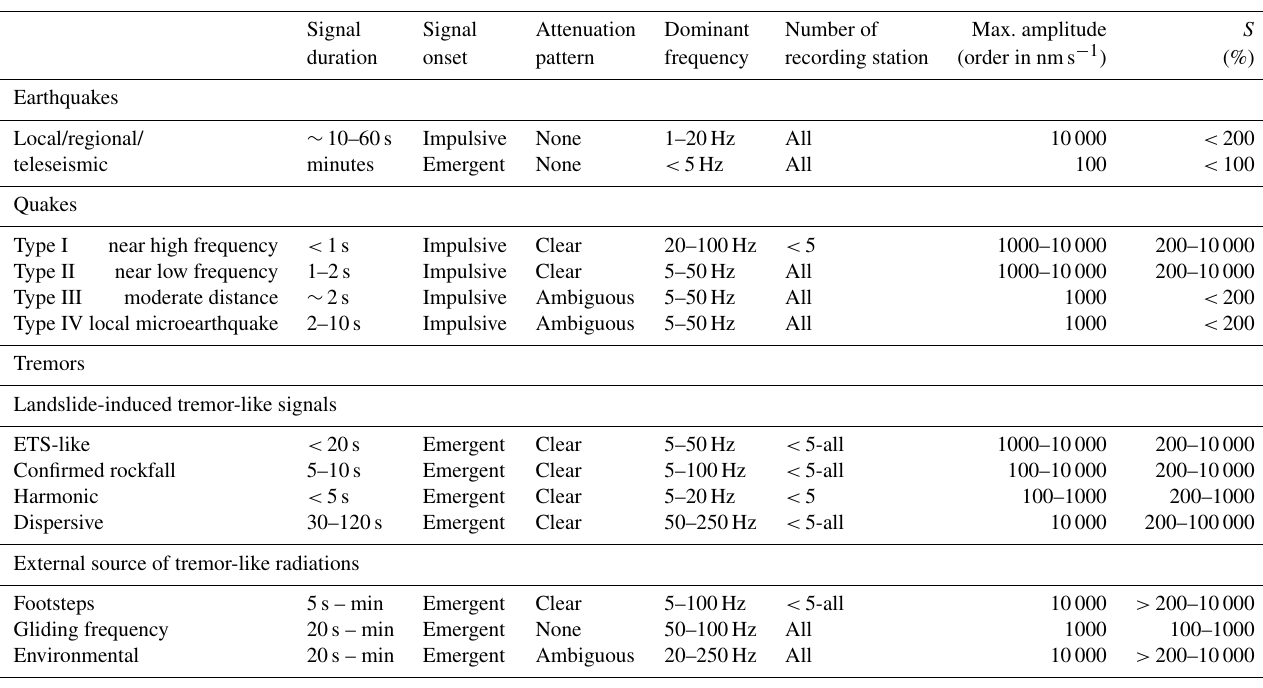
Table 1. Seismic features of microseismic signal types detected at slow-moving clay-rich debris slides. Features are indicated for high-SNR high-energy signals.